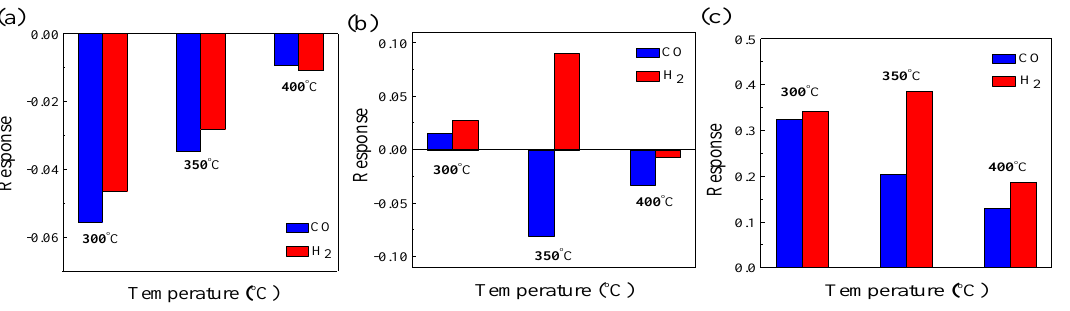
Figure 8. Response value of ZnO–0.425NiO annealed at ( a ) 500 °C, ( b ) 550 °C, ( c ) 600 °C to 400 ppm CO at di ff erent operating CO at different operating temperatures.